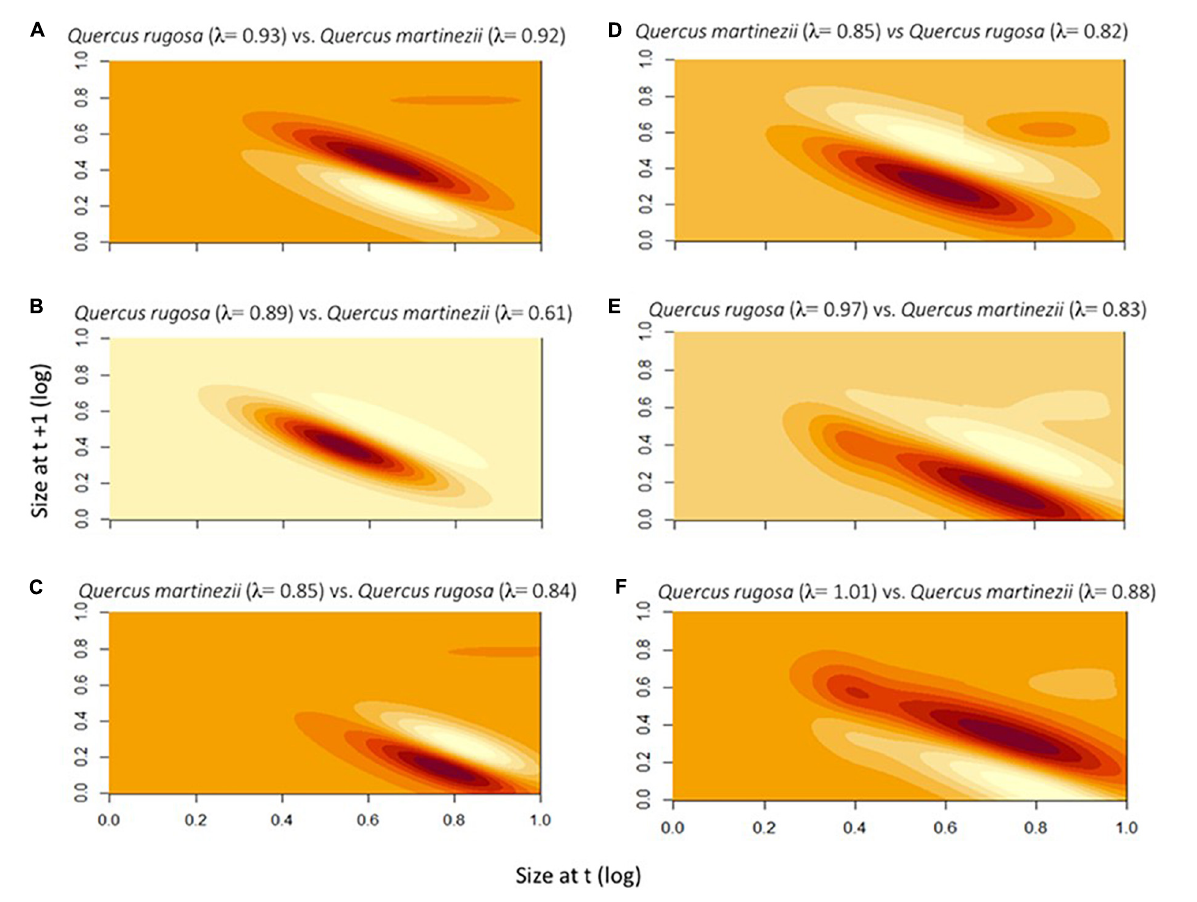
FIGURE5 Life table response experiment contributions for Alamania punicea (A–C) and Oncidium brachyandrum (D–F) plants growing on two Quercus species. Darker colors represent life-history transitions that make greater contributions to higher λ values observed. Values across the diagonal represent contributions from survival, and those below diagonal represent contributions from growth. Fecundity contributions are represented in the top right